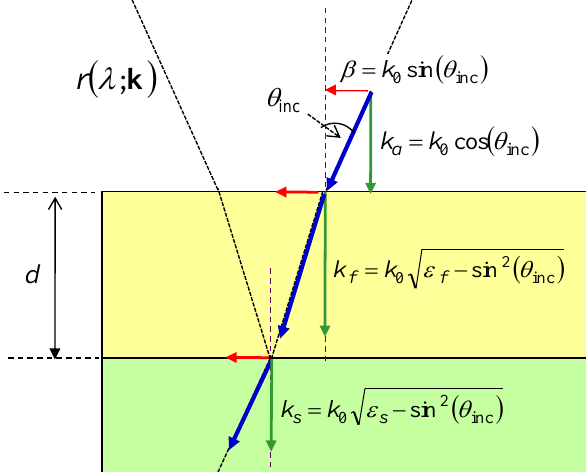
Figure A.1. Reflectance from a thin-film layer on a dielectric